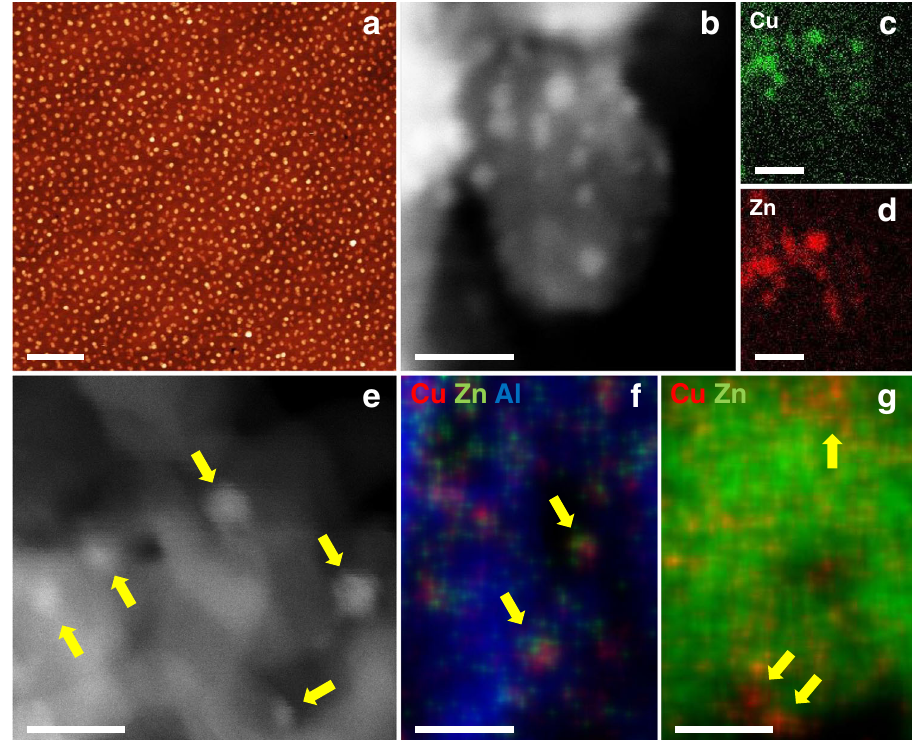
Fig. 1 Microscopy characterization of the catalysts. a AFM image of the Cu NPs supported on SiO 2 /Si(111). b STEM image of the CuZn/SiO 2 catalyst; c , d show the corresponding Cu and Zn EDX maps. e STEM image and f EDX map of the CuZn/Al 2 O 3 catalyst. g EDX map of the Cu/ZnO/Al 2 O 3 catalyst. In EDX maps f , g red represents Cu, green Zn and blue Al. The scale bars correspond to a 400 nm, b – g 10 nm.